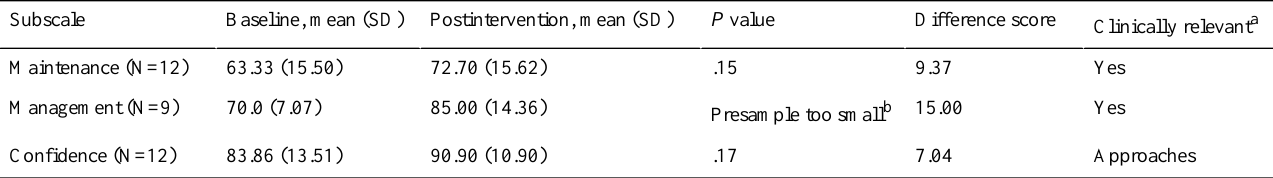
Table 3. Analysis of subscales of Self-Care of Heart Failure